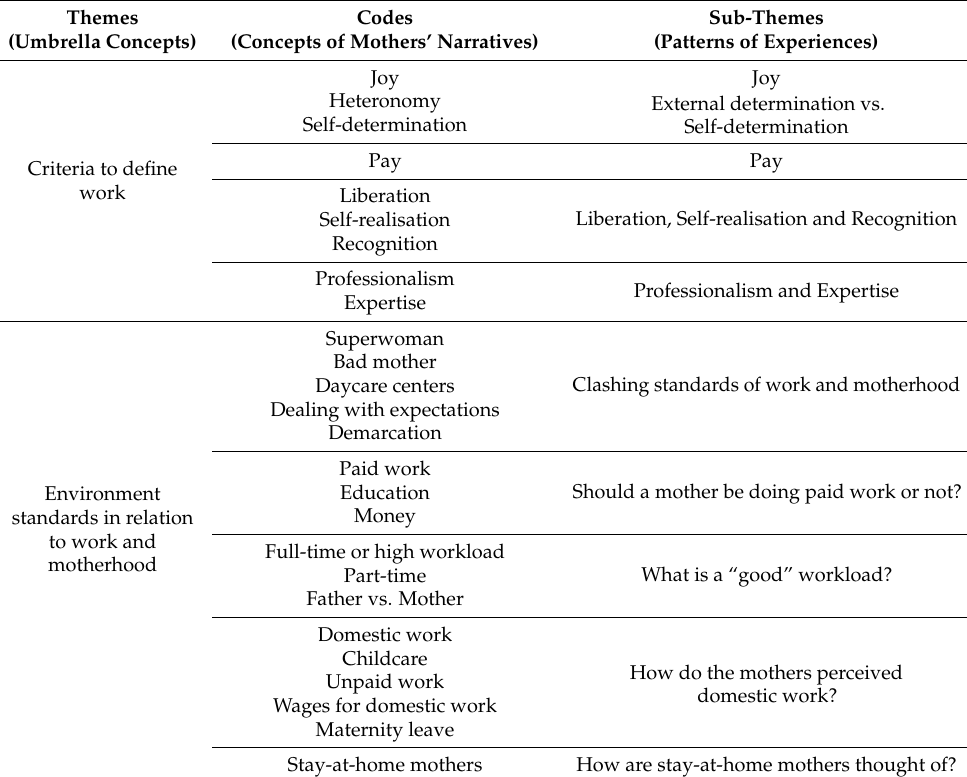
Table 1. The coding scheme of the study includes themes as umbrella concepts, the codes found in mothers’ interviews, and the sub-themes, which were found as patterns of common